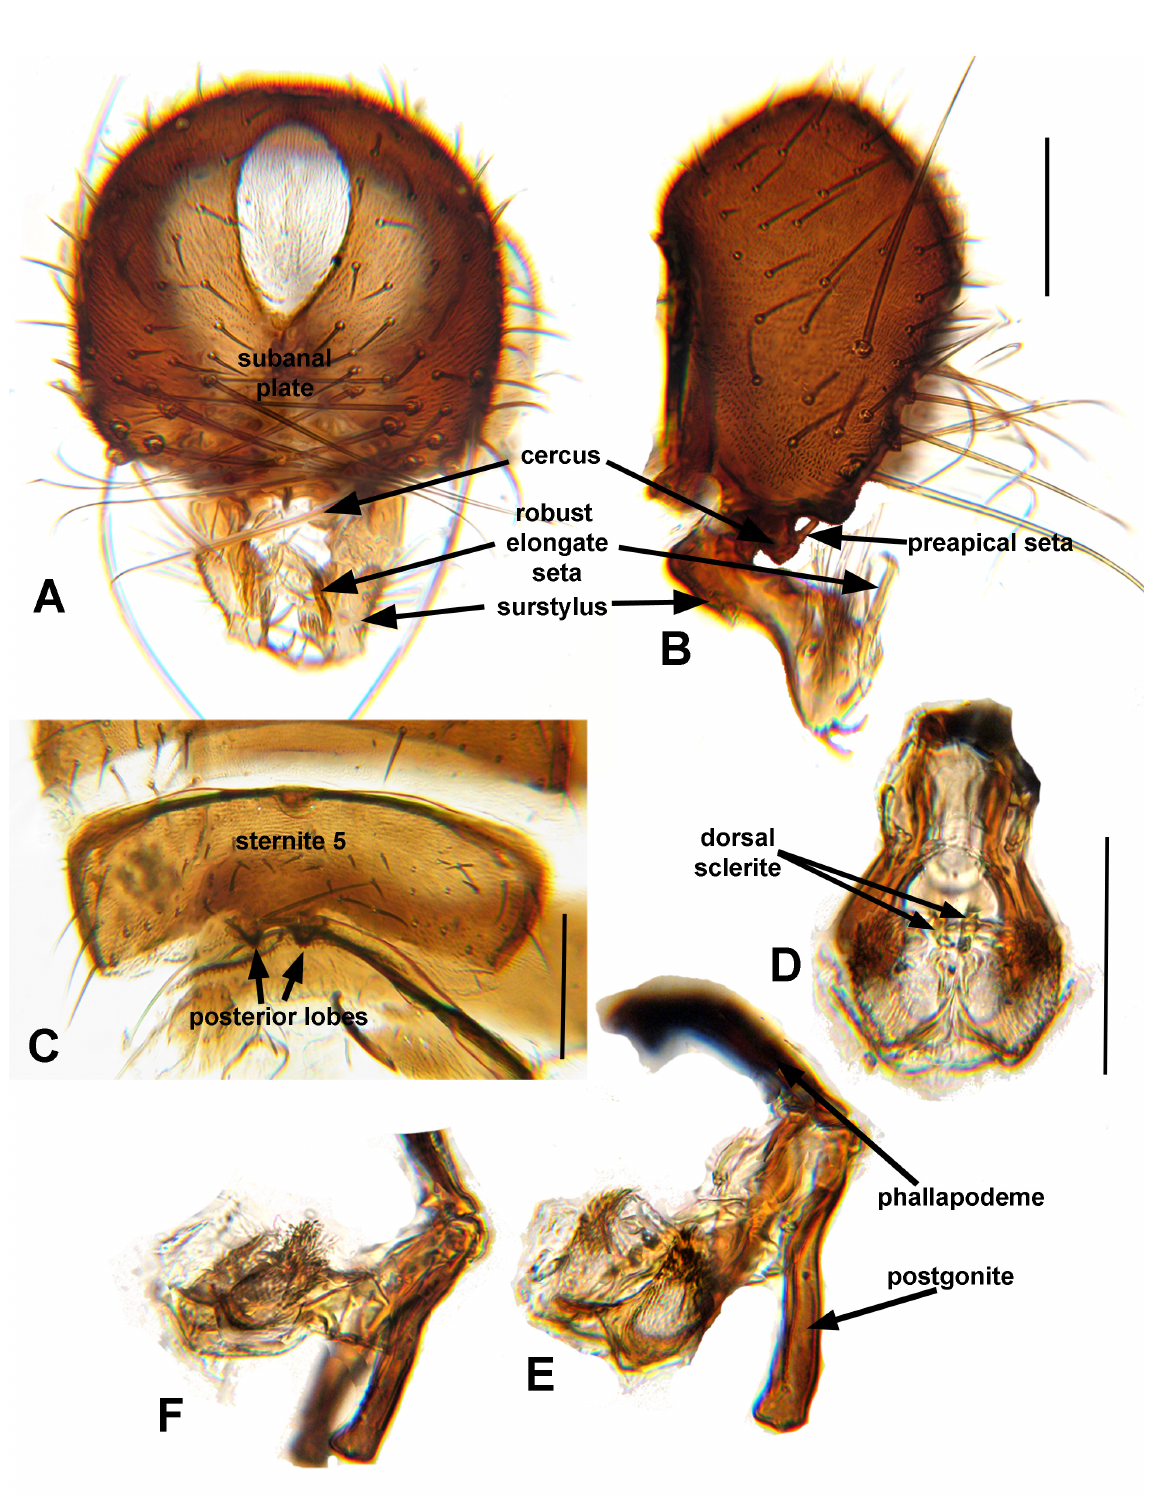
Fig. 8 . Rudolfina bucki sp. nov., male terminalia (debu01086239). A . Epandrium, surstylus and cercus, caudal view. B . Same as preceding, lateral view. C . Sternite 5, ventral view. D . Phallus, dorsal view. E . Phallus, postgonite and phallapodeme, dorsolateral view. F . Same as preceding, lateral view. Scale bars: A–B = 0.10 mm; C = 0.10 mm; F =